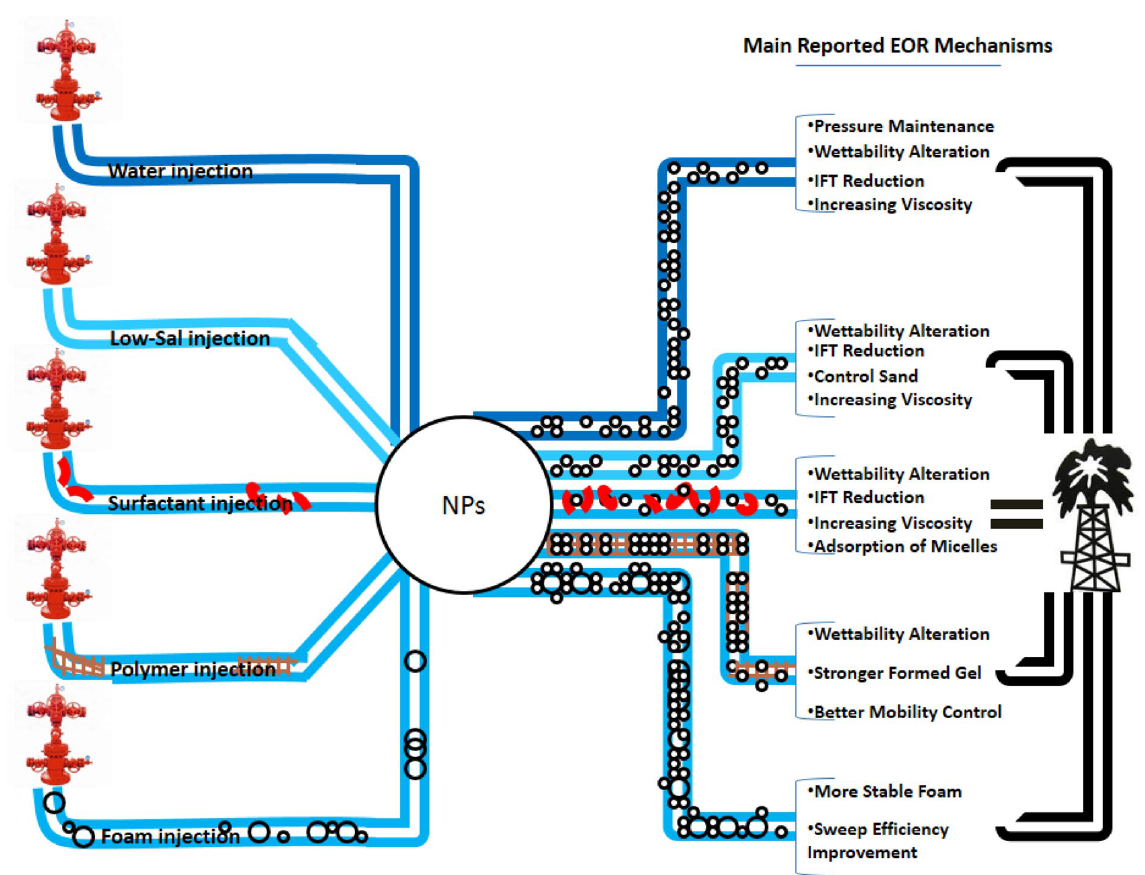
Fig. 8 Schematic illustration of the main advantages of using NPs in EOR